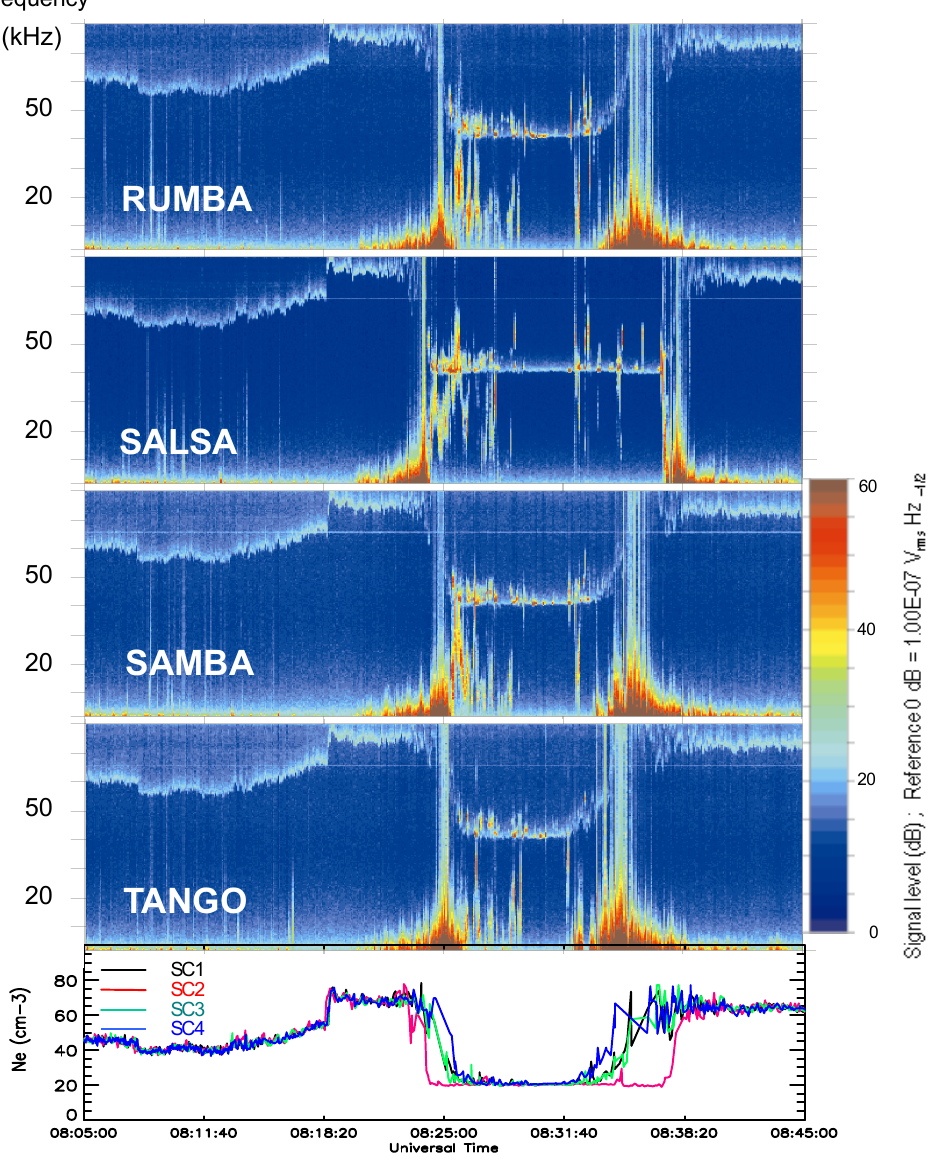
Fig. 9. Frequency/time spectrograms of the four spacecraft during a bow shock crossing (22 December 2000), and the corresponding density profiles (bottom panel). The RUMBA (spacecraft 1), SALSA (spacecraft 2), SAMBA (spacecraft 3) and TANGO (spacecraft 4) spacecraft are located at 17:00LT, close to apogee (12 ◦ latitude, 19.5 R E